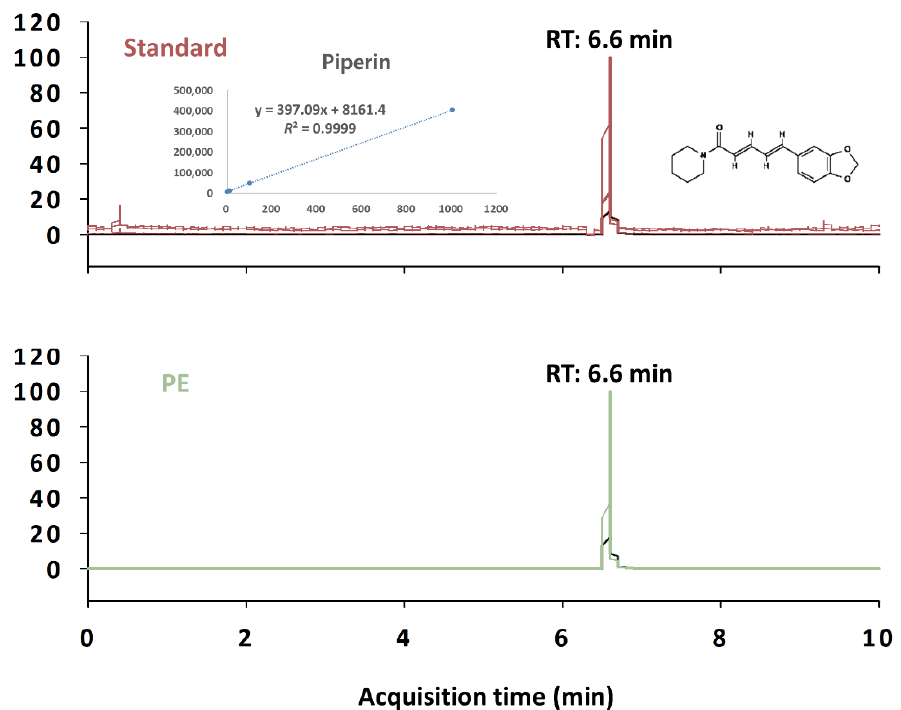
Figure 1. Representative LC–MS/MS of piperine in Piper nigrum extract (PE). RT: retention time.